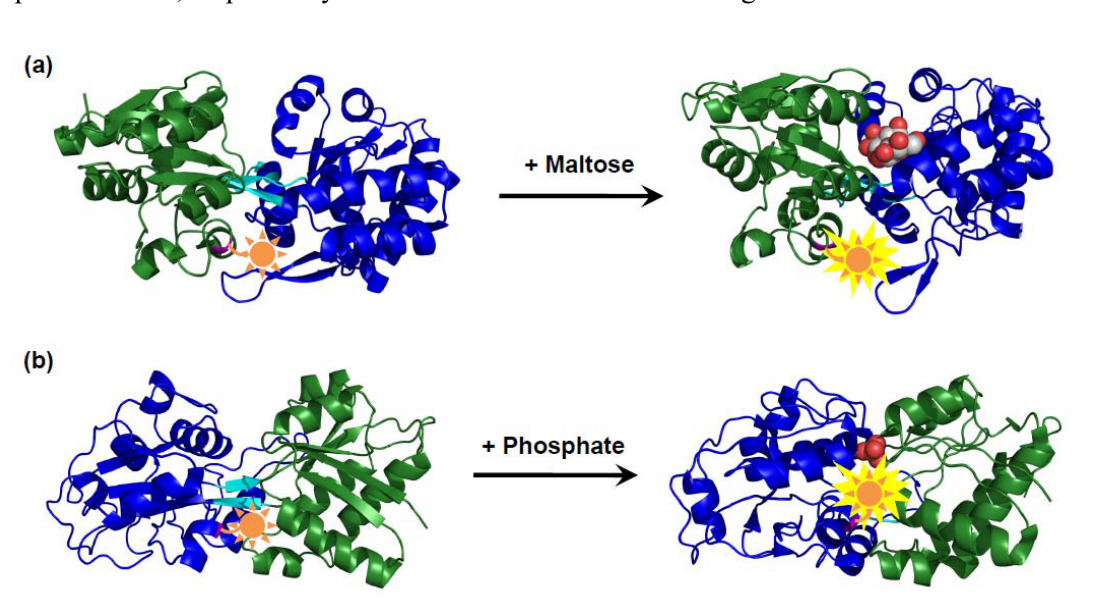
(b) inorganic phosphate [93]. The maltose-binding protein (MBP) and